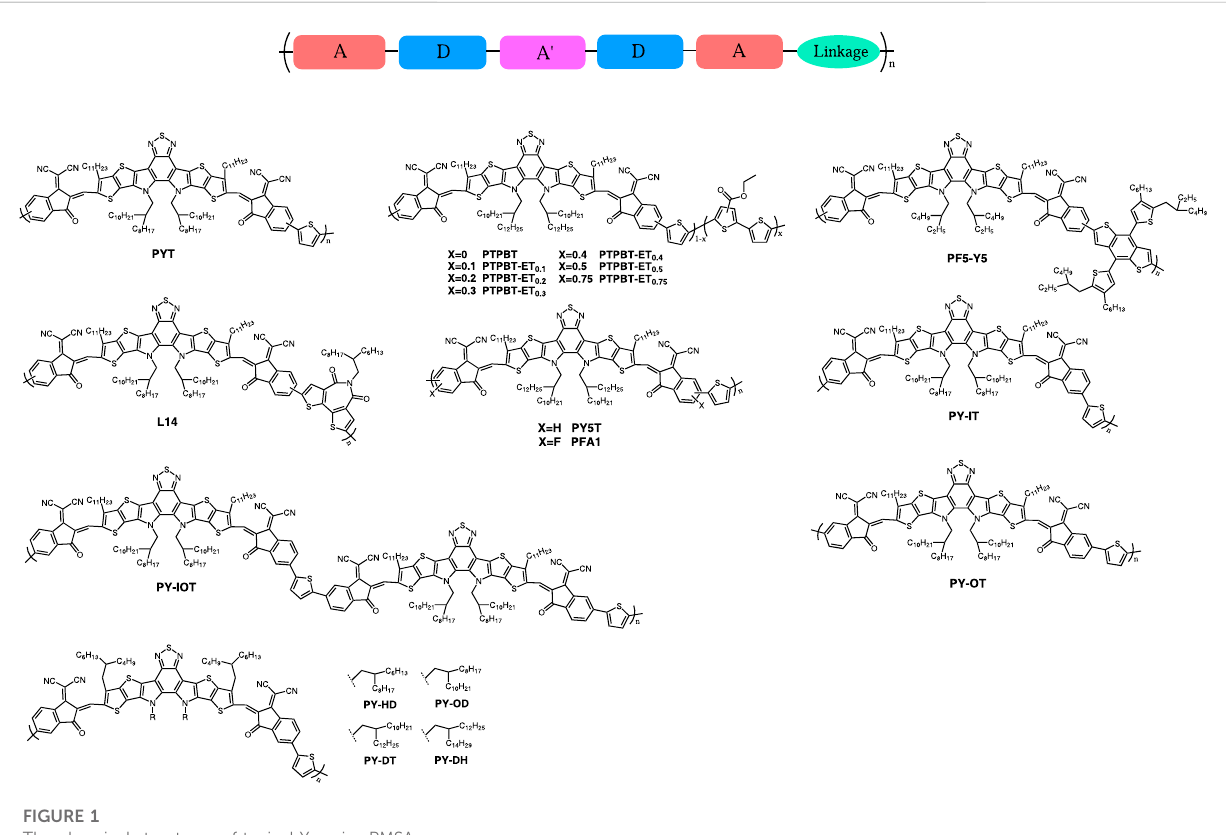
FIGURE 1 The chemical structures of typical Y-series